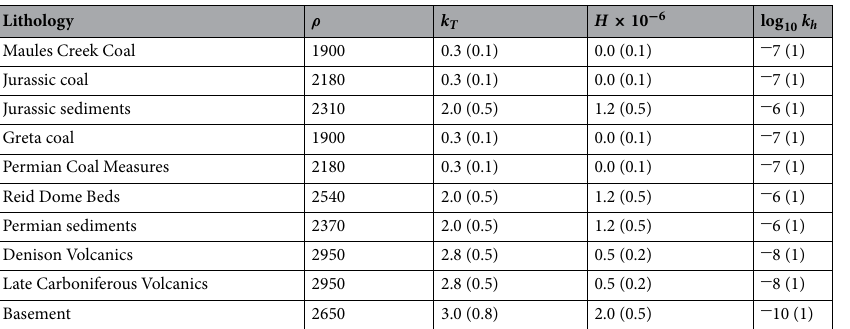
Table 1. Material properties assigned to major lithologies in the Sydney–Gunnedah–Bowen Basin. Bracketed numbers indicate one standard deviation from the mean—i.e. mean (std). Units are ρ = density (kg m −